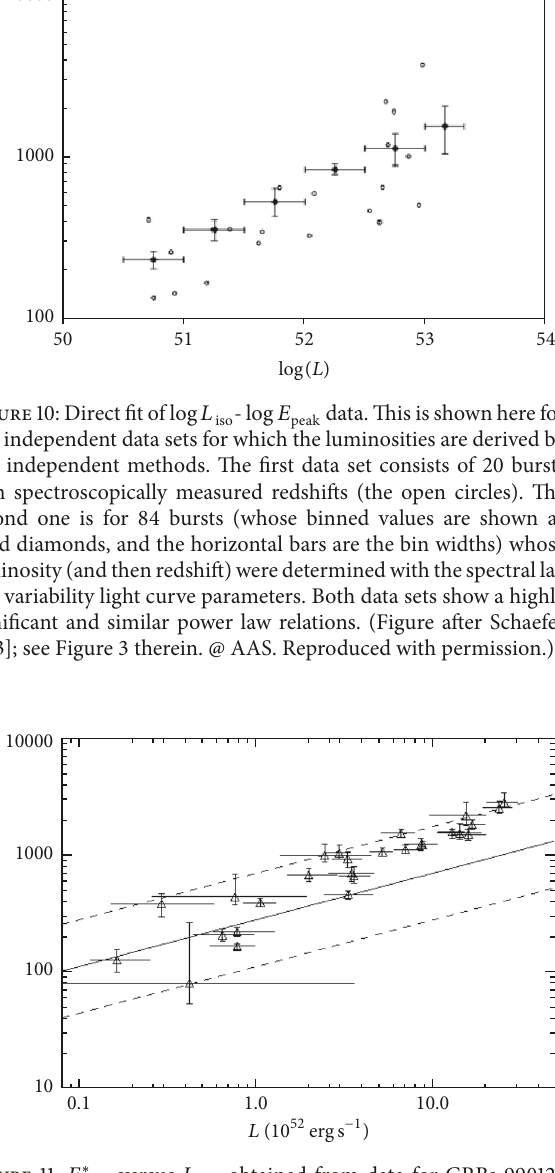
Figure 11: 𝐸 ∗ versus 𝐿 , obtained from data for GRBs 990123 iso peak and 990510. The solid line is the best-fit power law. (Figure after Frontera et al. [200]; see Figure 6 therein. @ AAS. Reproduced with